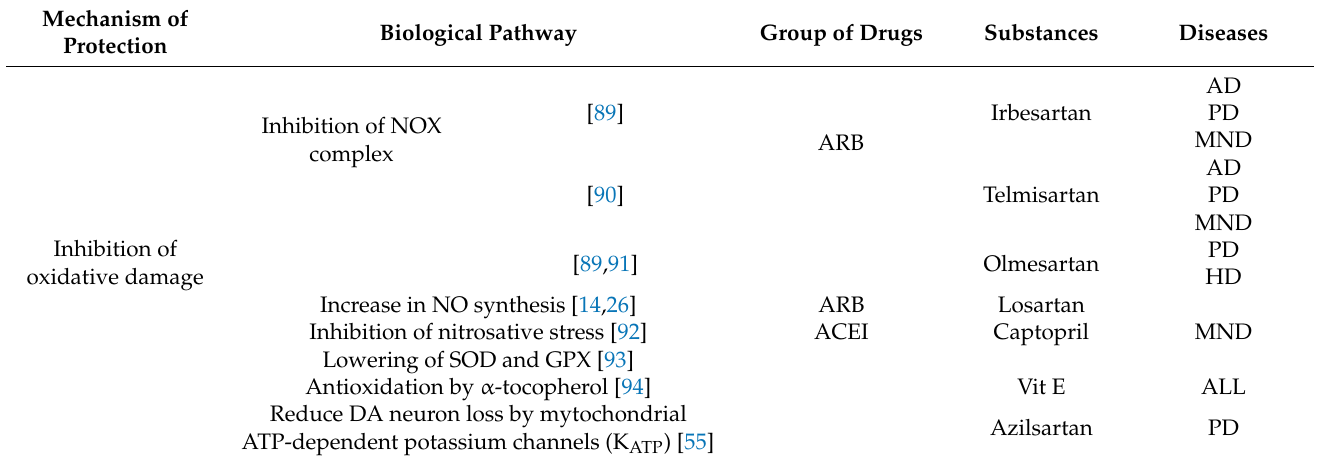
Table 3. Protective mechanisms of RAS pharmacological modulators via the inhibition of oxida- tive damage.